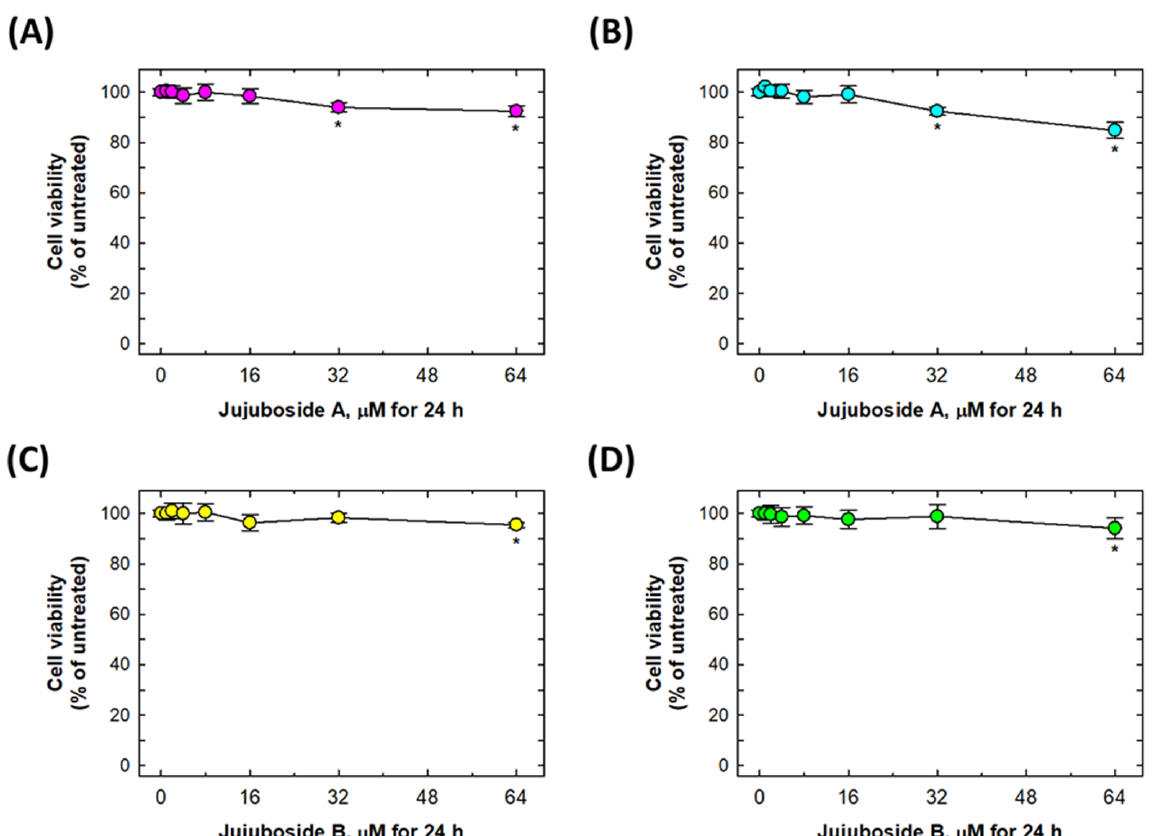
Figure 2. Suppressive effects of jujuboside A and B on cell viabilities in SH-SY5Y and SK-N-SH cells. ( A , B ) Suppressive effects of jujuboside A on SH-SY5Y and SK-N-SH cells, respectively. ( C , D ) Suppressive effects of jujuboside B on SH-SY5Y and SK-N-SH cells, respectively. * Statistically significant from untreated group. Each experiment was repeated for at least 6 times.